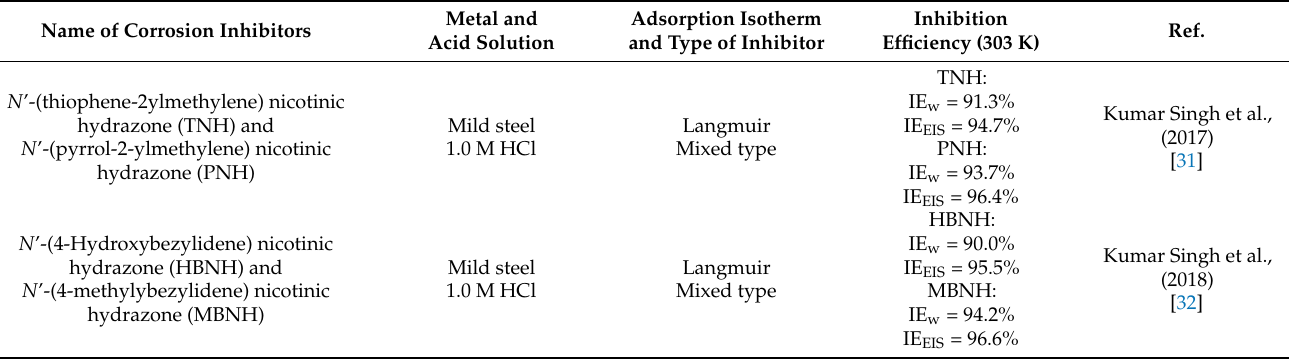
Table 1. Fatty hydrazide derivatives used as a corrosion inhibitor for various steel samples. Metal and Adsorption Isotherm Name of Corrosion Inhibitors Acid Solution and Type of